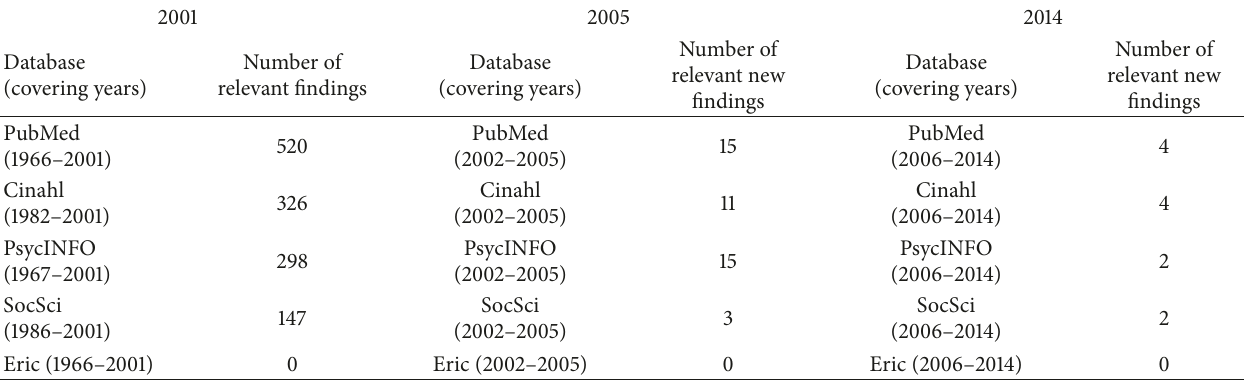
Table 1: Searches made in the different data bases during the years. The searches in 2001 started from the year of the start of the respective